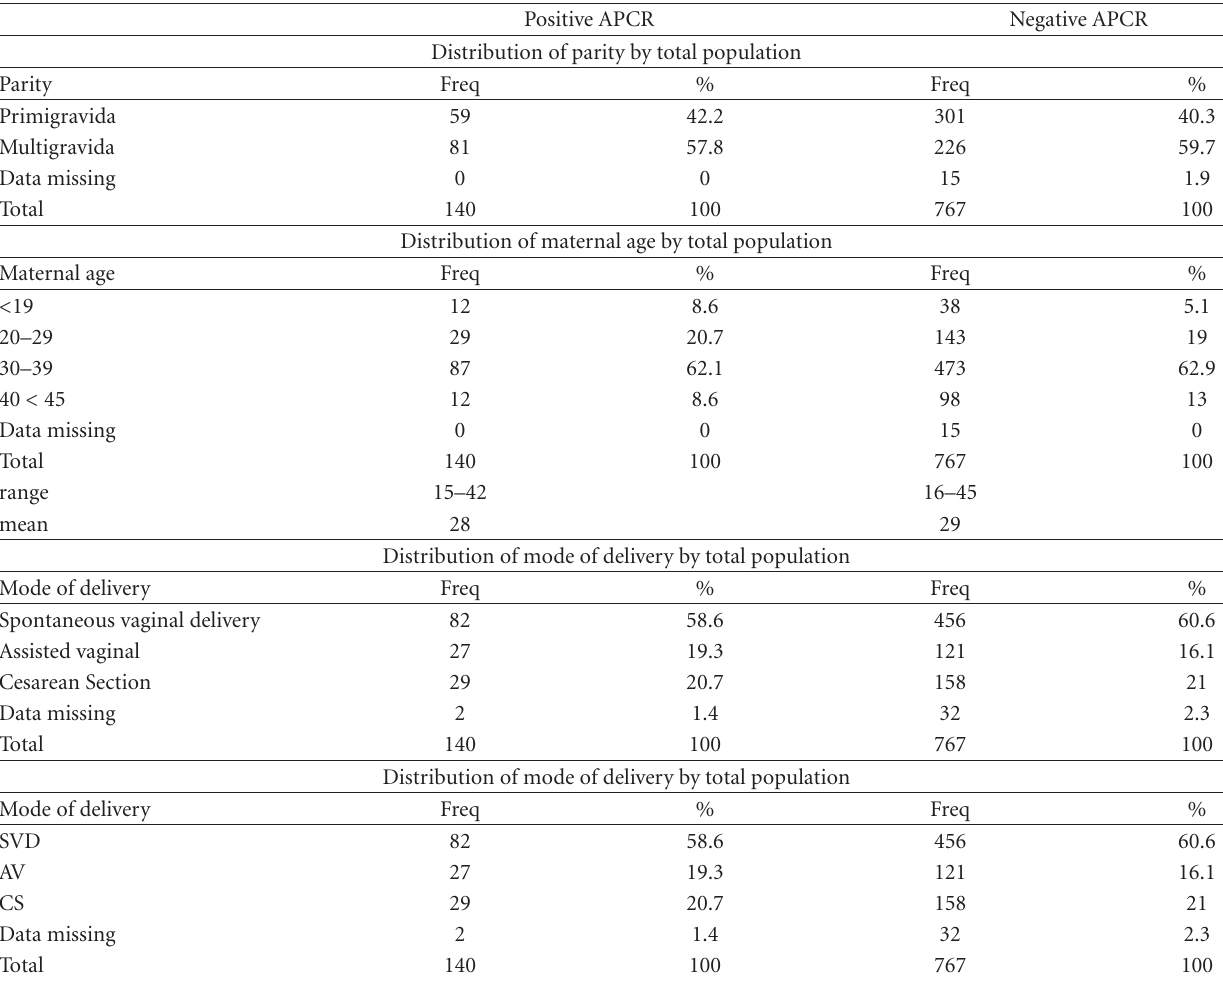
Table 1: Demographics of study cohort ( n = 907) pregnant woment attending for antenatal care at UCH, Galway. Positive APCR Negative APCR Distribution of parity by total